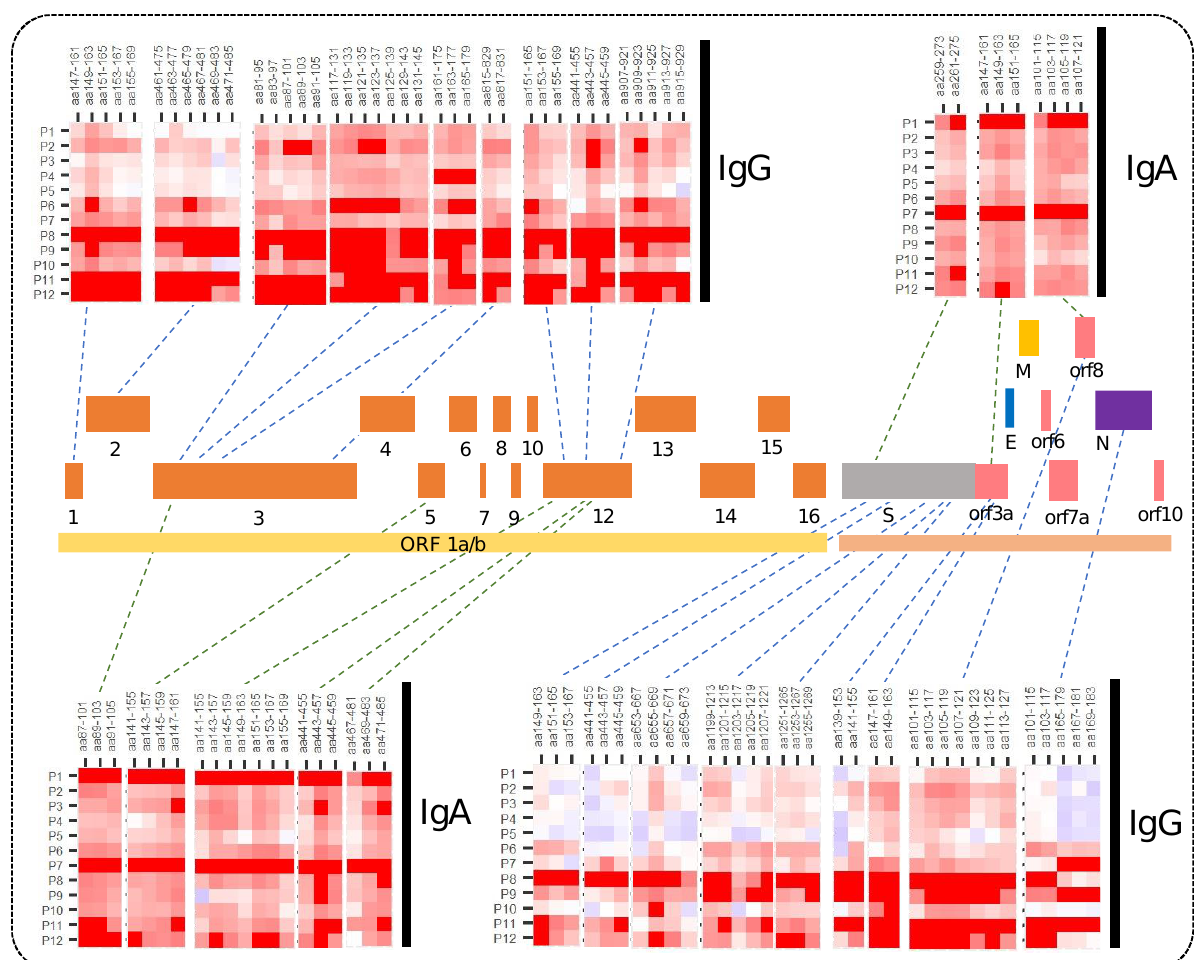
Figure 2. Heatmaps for IgA and IgG response showing major immunogenic regions identified in the SARS-CoV-2 whole proteome microarray. The printed proteome constitutes ORF1a/b polyprotein encoding 16 non-structural proteins (1 – 10 and 12 – 16), structural proteins (S, N, E, and M), and the accessory proteins (ORF3a, 6, 7a, 8, and 10).